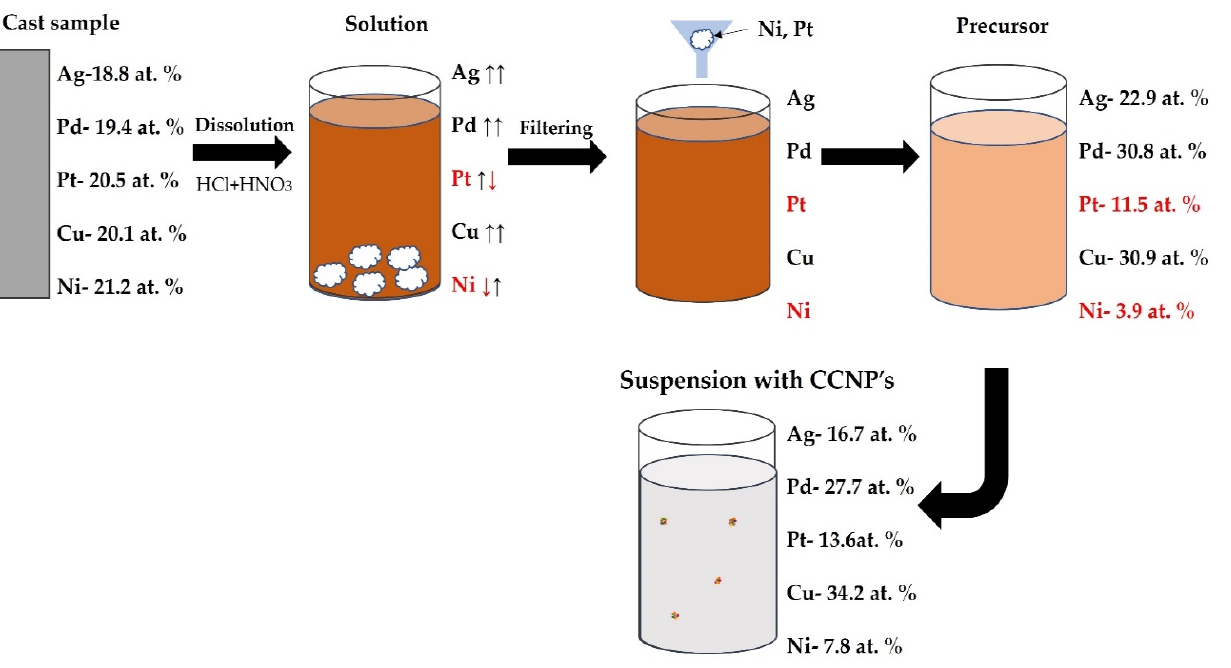
Figure 11. Schematic representation of the hydrometallurgical treatment of dissolution and precursor preparation. Table 4. Mixing enthalpies of binary systems